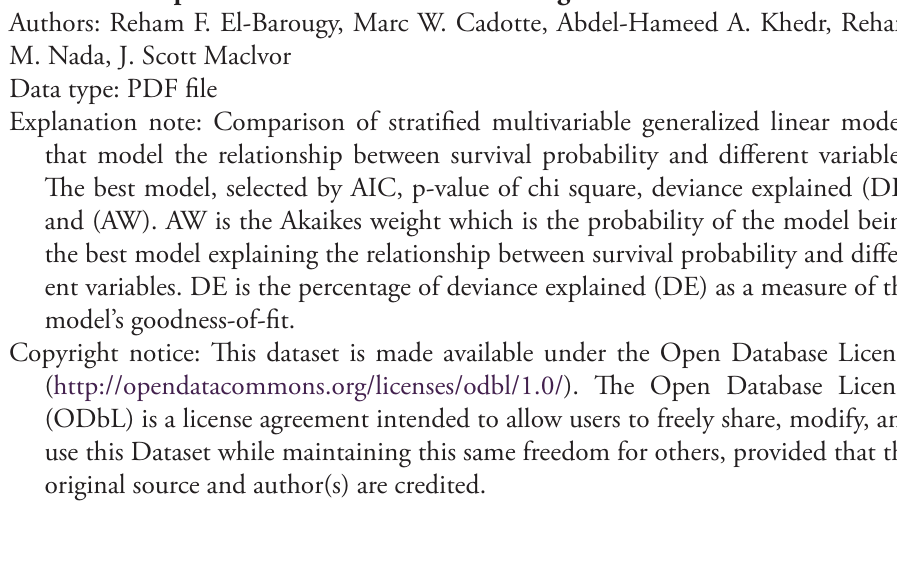
Table 1S. Comparison of stratified multivariable generalized linear